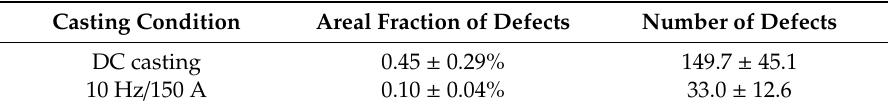
Table 2. The statistical results of the casting defects in the SAM images of 2A97 as-cast ingots. Casting condition